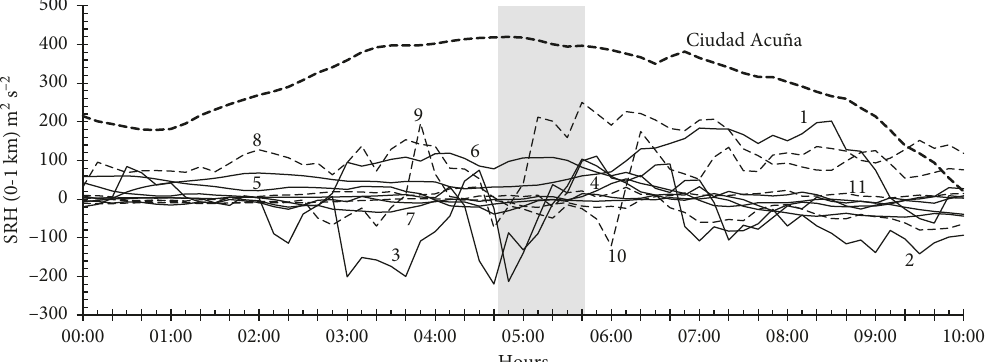
Figure 2: Time series of storm-relative helicity (SRH) of 12 tornadoes in the Trans-Mexican Volcanic Belt (TMVB) region: seven clockwise- rotating tornadoes (continuous lines marked as 1 to 7) and 5 anticlockwise-rotating tornadoes (dashed lines marked as 8 to 11) are shown. The Ciudad Acuña event (mesocyclonic tornado) is marked at the top of the graph. The shaded region illustrates the time-period when tornadoes